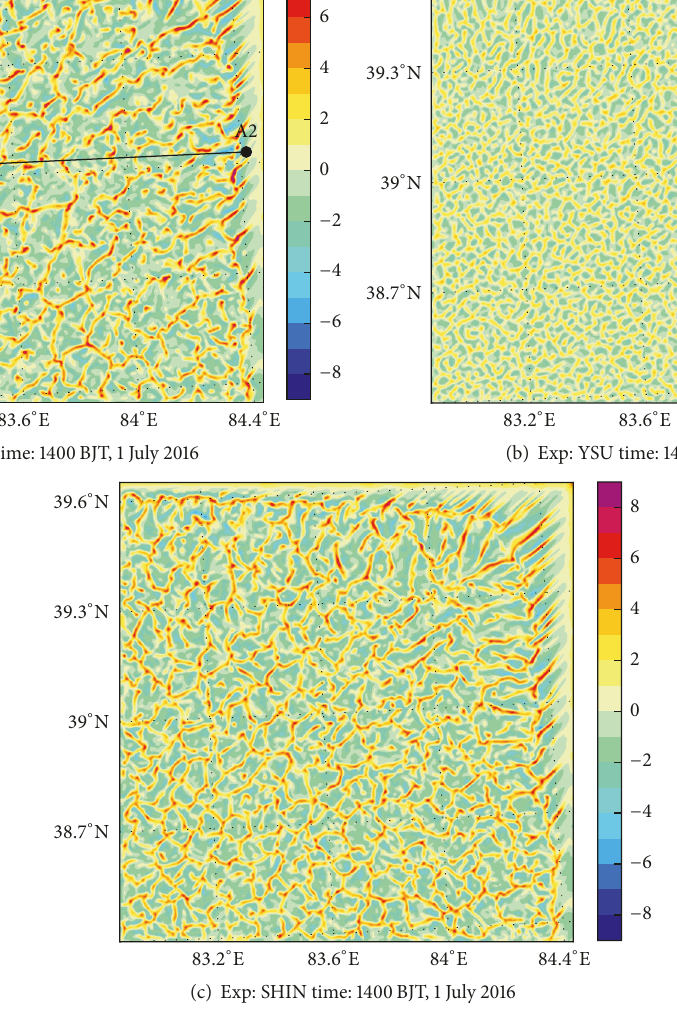
Figure 8: Instantaneous vertical velocity fields (shading: m/s) at 3000 m for (a) WRF-LES, (b) YSU, and (c) Shin-Hong at 1400BJT, 1 July